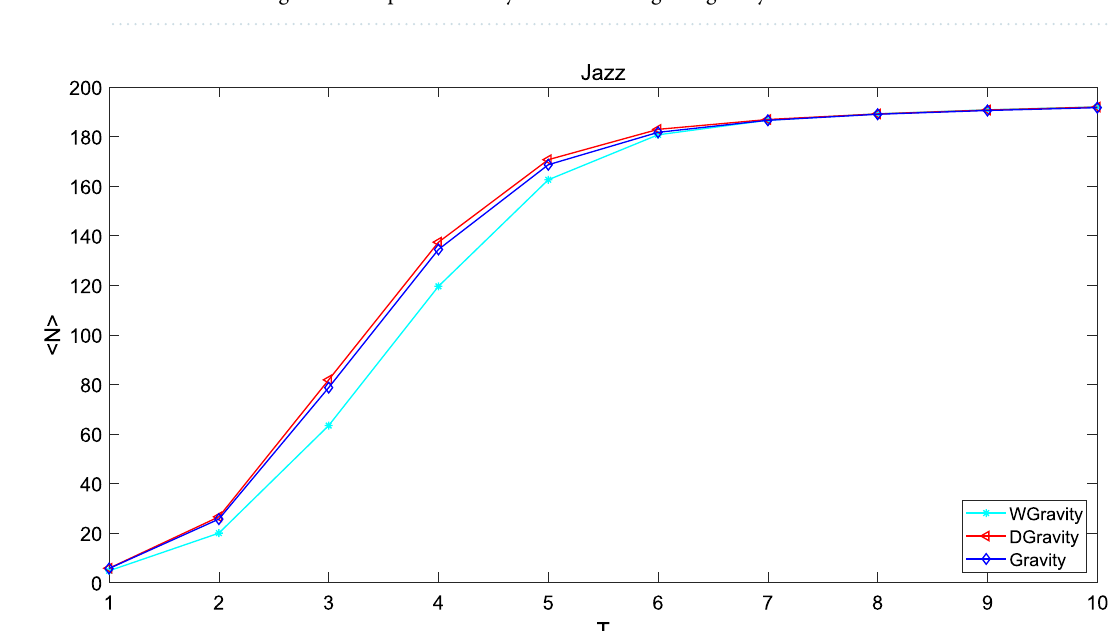
Figure 11. The figure describes the correlation between the new model and other methods in USAir. The new model shows strong relationship with Gravity model and weighted gravity model.